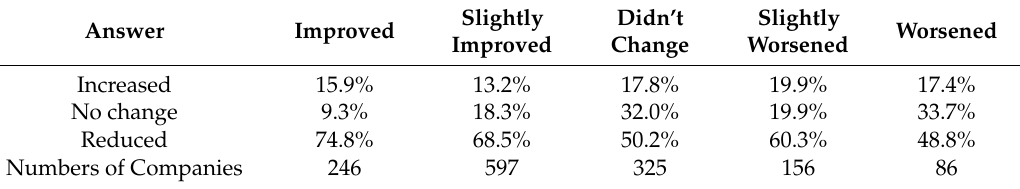
Table 6. Total debt balance from financial institutions (changes since the Financing Facilitation Act was